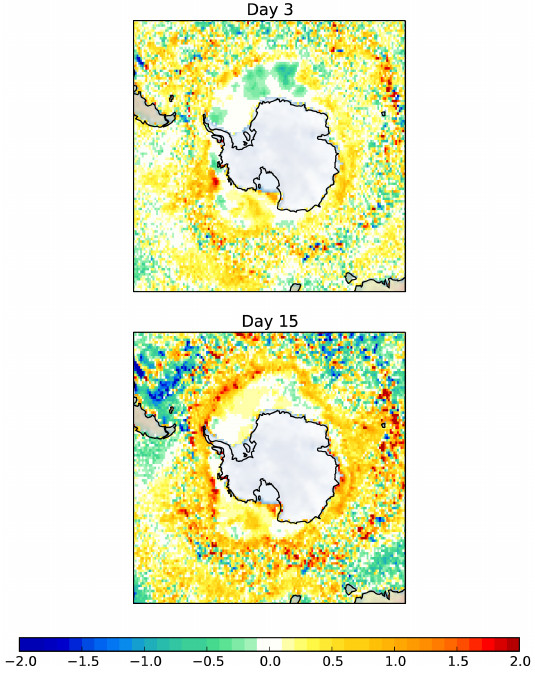
Figure 3. Mean day 3 and day 15 SST bias (K) against analyses in the NWP experiment.